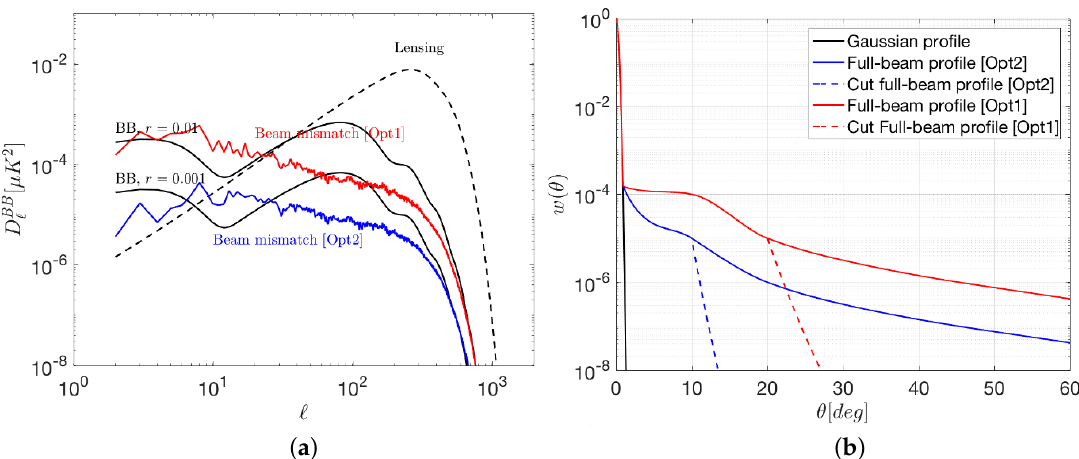
Figure 6. BB signals ( a ) produced by the FSL of two non-ideal beam models ( b ) with FWHM = 30 arcmin and for a frequency of 140 GHz. Red lines (option 1): spurious signal produced by FSL placed at more than 20 ◦ from the beam center. Blue lines (option 2): spurious signal produced by FSL placed at more than 10 ◦ from the beam center. Primordial B-mode (solid black lines) for two values of r and gravitational lensing B-mode (dashed black) spectra are also plotted in ( a ) for